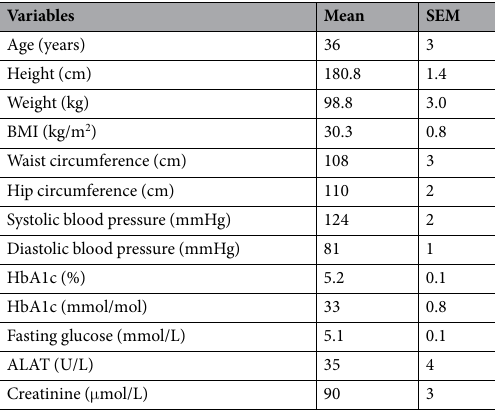
Table 1. Participants’ baseline characteristics. n = 12; Values are represented as mean ± standard error of